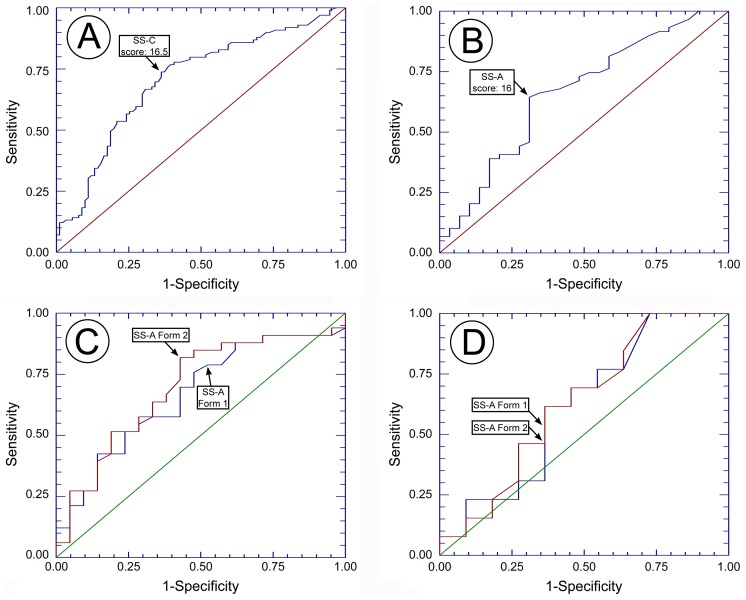
Receiver operating characteristics (ROC) curves for SS-C (A) and SS-A (B) indicating the designated cut off points at 16.5 and 16, respectively.The points at the ROC curve at the designated cut offs for SS-C (C) and SS-A (D) forms 1 and 2 are also illustrated.